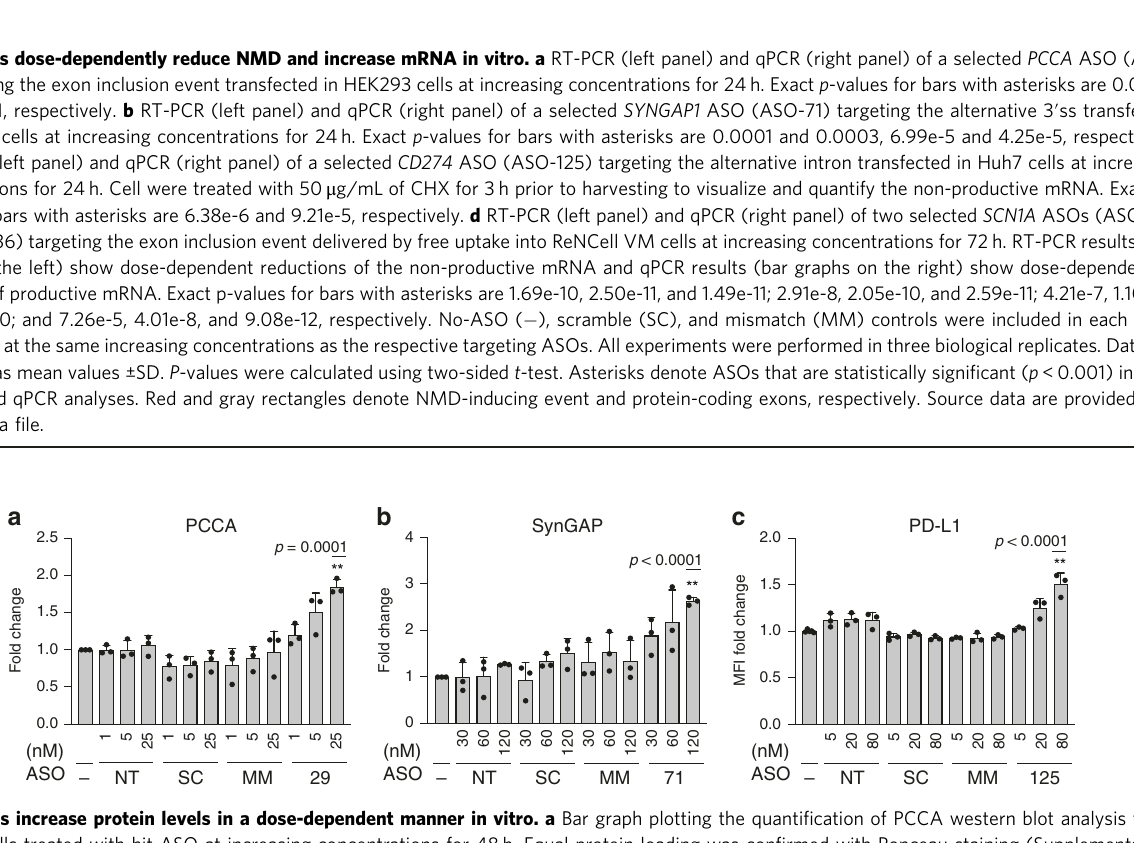
Fig. 5 ASOs increase protein levels in a dose-dependent manner in vitro. a Bar graph plotting the quanti fi cation of PCCA western blot analysis from HEK293 cells treated with hit ASO at increasing concentrations for 48 h. Equal protein loading was con fi rmed with Ponceau staining (Supplementary Fig. 5). b Same for SynGAP ( p = 4.62e-6). c Bar graph plotting fl ow cytometry derived fold change of the Mean Fluorescent Intensity of PD-L1 from Huh7 cells treated with the hit ASO at increasing concentrations for 120 h. No-ASO ( − ), scramble (SC), and mismatch (MM) controls were included in each experiment at the same increasing concentrations as the respective targeting ASOs ( p = 7.70e-5). All experiments were performed in three biological replicates. Data are presented as mean values ±SD. P -values were calculated based on two-sided t -test. Asterisks indicate p < 0.001. Source data are provided as a Source Data fi